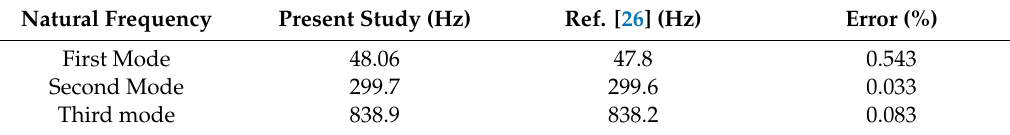
Table 6. Comparison between the natural frequencies when R l = 100 Ω .